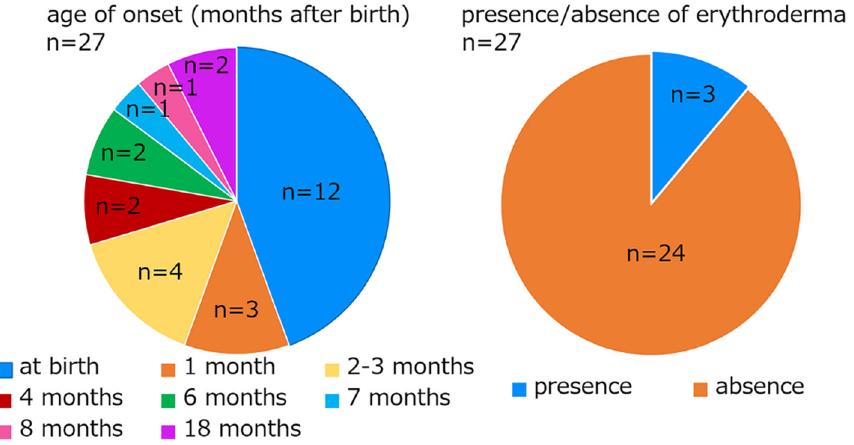
Figure 2. The age of onset and the presence/absence of erythroderma in SEI patients with the KRT2 mutation p.Glu487Lys. Only the cases with clinical information are included in this figure.